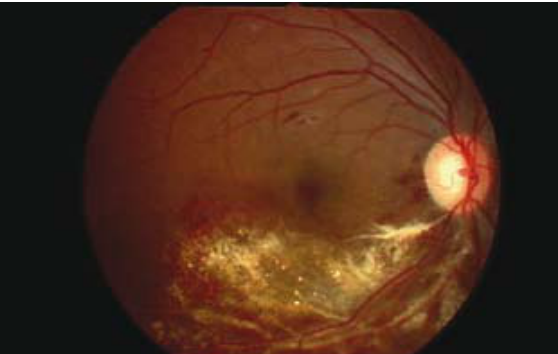
Fig. 2. CMV retinitis after six intra-ocular ganciclovir injections. Note scarring in the area of previous necrosis. There is less vitritis, and the macular oedema has resolved. Haemorrhages may take months to resolve, and intraretinal gliosis can usually be seen late (courtesy Dr Linda Visser, University of